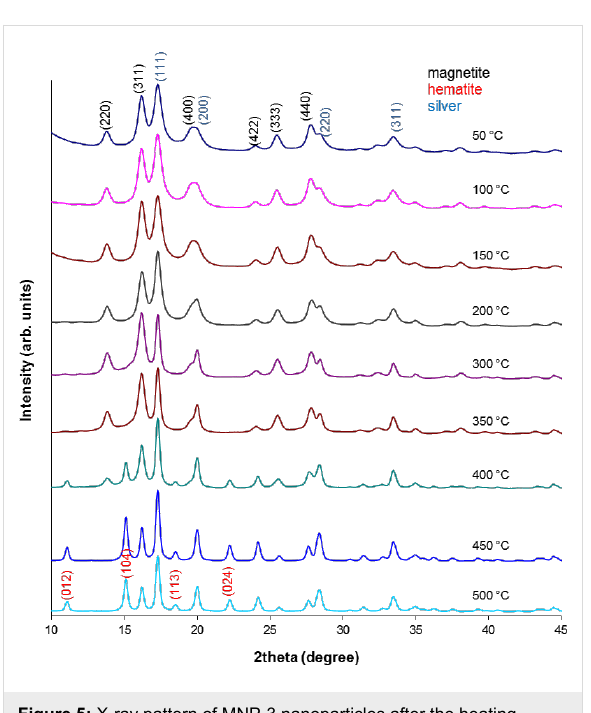
Figure 5: X-ray pattern of MNP-3 nanoparticles after the heating process.